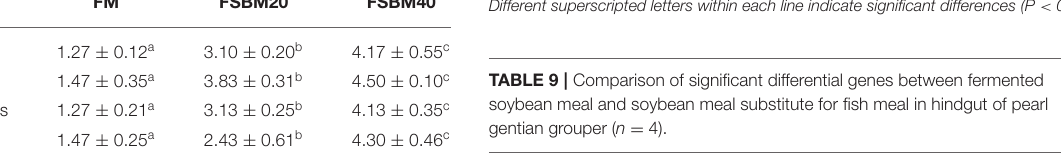
TABLE 5 | Semi-quantitative histological evaluation of intestinal sections ( n = 10). Parameters